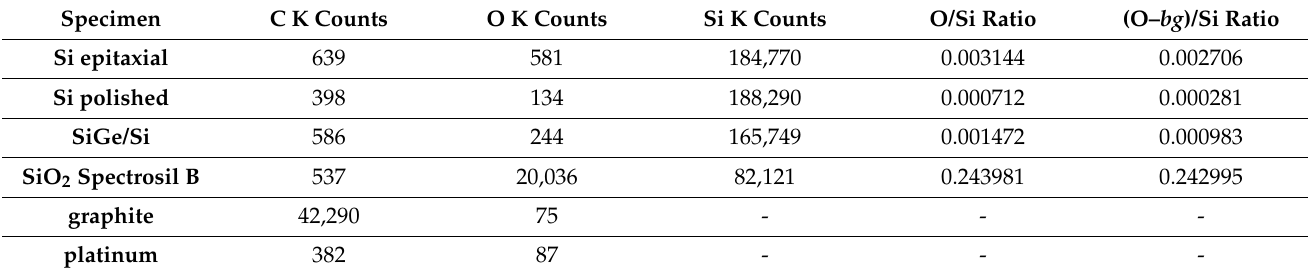
Figure 8. Bright field transmission electron microscopy (TEM) image of sample 22C86, showing from top in cross-section: glue line/6.5 ± 0.3 nm SiO 2 /66.5 nm Si 0.83 Ge 0.17 /Si(001). Table 1. Numerical results for intensities measured from spectra in Figure 7. Colour code correlates with those of spectra in Figure 7. The O K counts from the graphite and platinum standards used as blanks in Figure 7b amount to 75 and 87 counts, respectively, yielding on average an apparent oxygen background signal, bg = 81 ± 6 counts, for the O K-line at 300